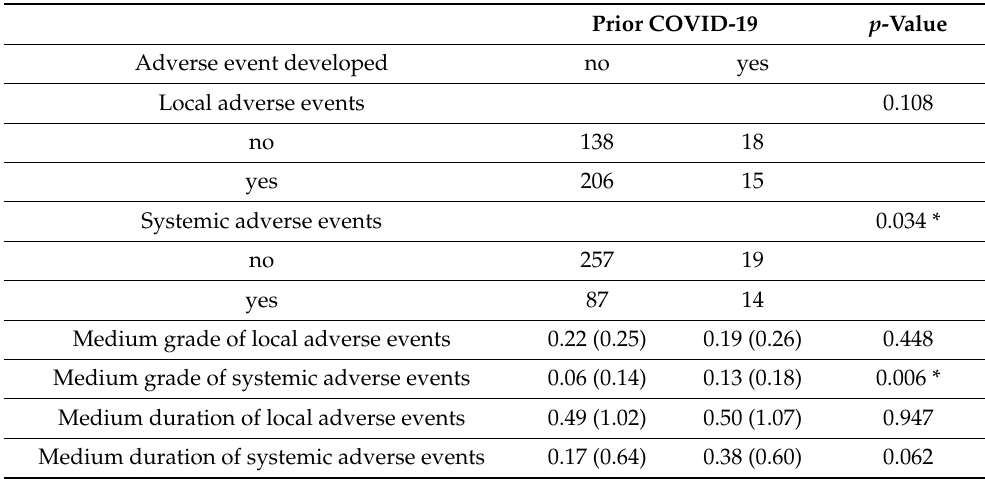
Table 6. Comparison between previous COVID-19 and adverse events after the first dose. Statistics: absolute frequency or mean (sd). *: p -values reaching statistical